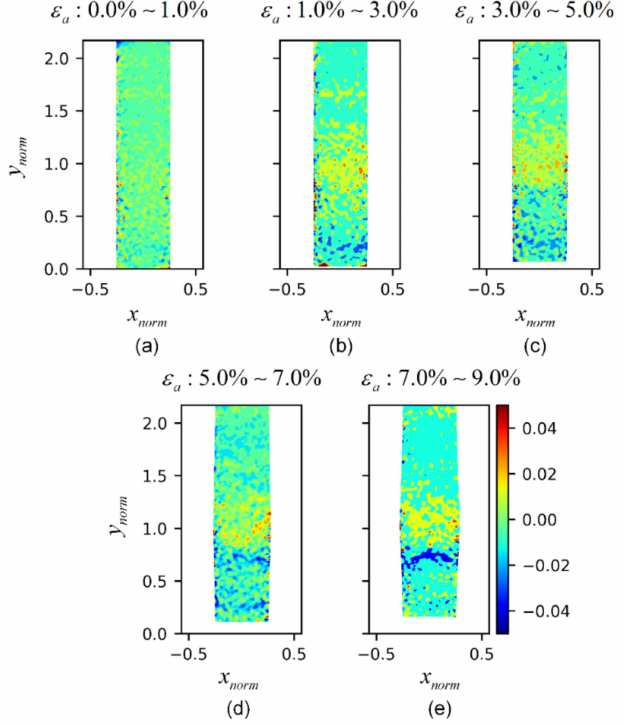
Figure 21. Evolution of divergence field div U of test 121304b: ( a ) axial strain 0.0%–1.0%; ( b ) axial strain 1.0%–3.0%; ( c ) axial strain 3.0%–5.0%; ( d ) axial strain 5.0%–7.0%; ( e ) axial strain